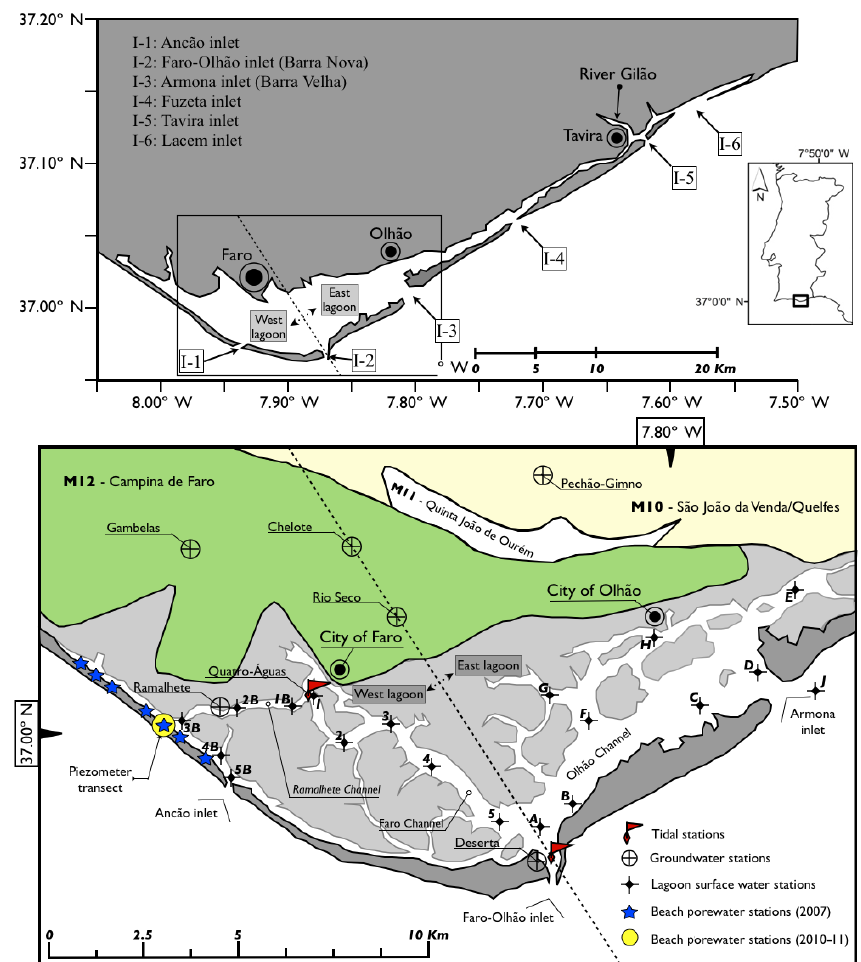
Figure 1. Map showing the locations of the sampling sites within the Ria Formosa and its geographical context. The top panel shows the full geographical extent of the system, with the operational separation of the region of interest into western and eastern lagoons and the names of all the inlets. The lower panel shows an amplified map of the region of interest, including major channels, locations of sampling and tidal stations, as well as boundaries of the aquifers bordering the lagoon (M10, M11,